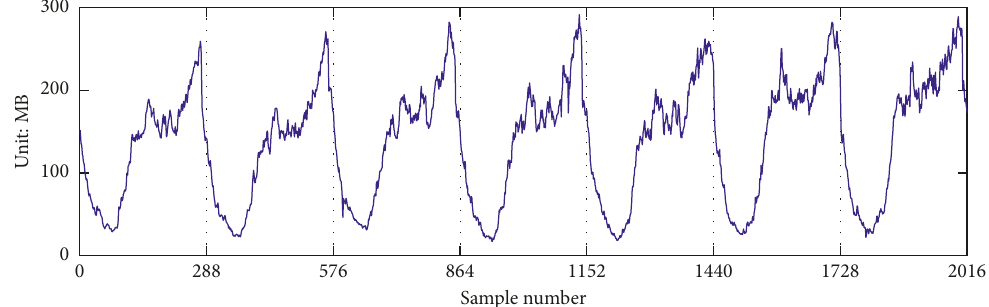
Figure 3: The inflow network traffic data.